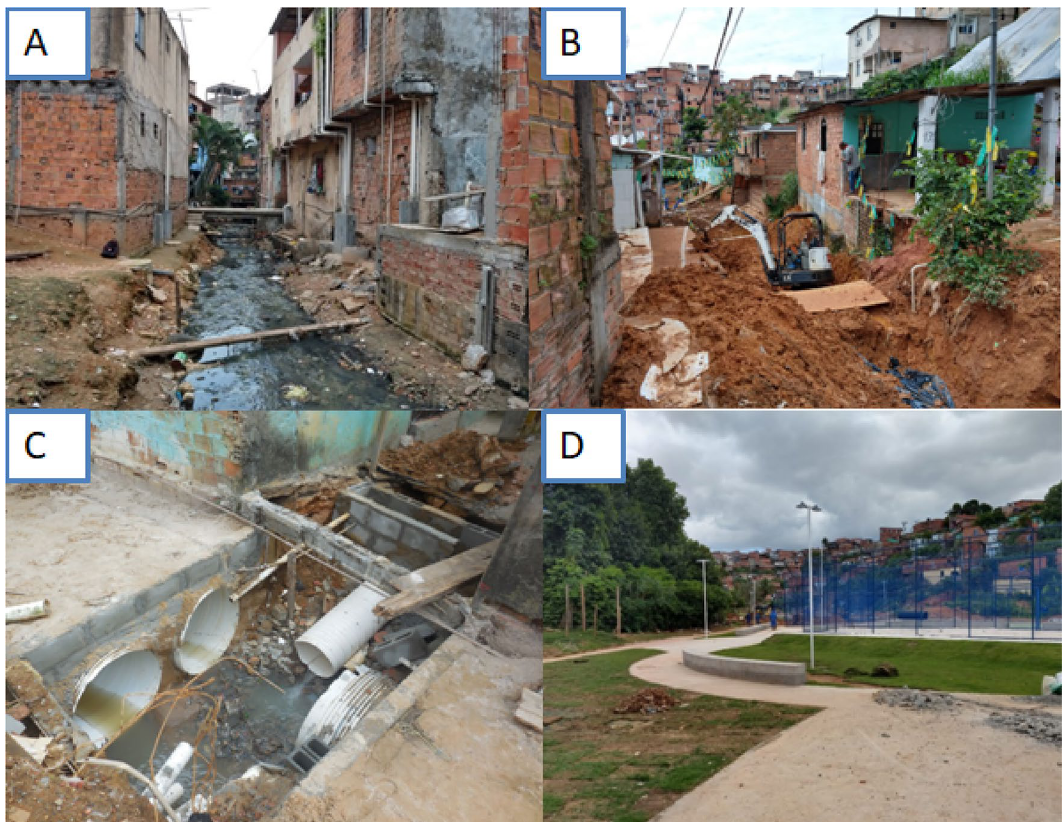
Figure 2. ( A , B ) An open sewer between households in the study area, ( C , D ) The study area undergoing environmental modification i.e. channeling of the drainage into a major junction, and the construction of community square, roadway and sidewalk. The figure photographed by Fabio Neves Souza, Institute of Biology, Federal University of Bahia,